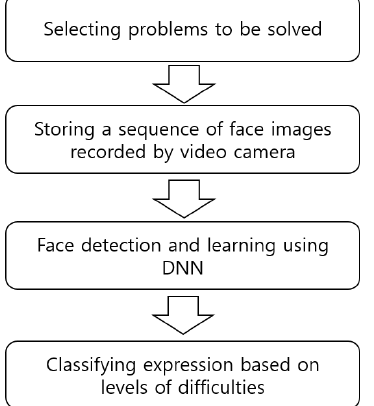
Figure 5. Overall flow of the experiments conducted in this research to establish a framework for process-focused assessment